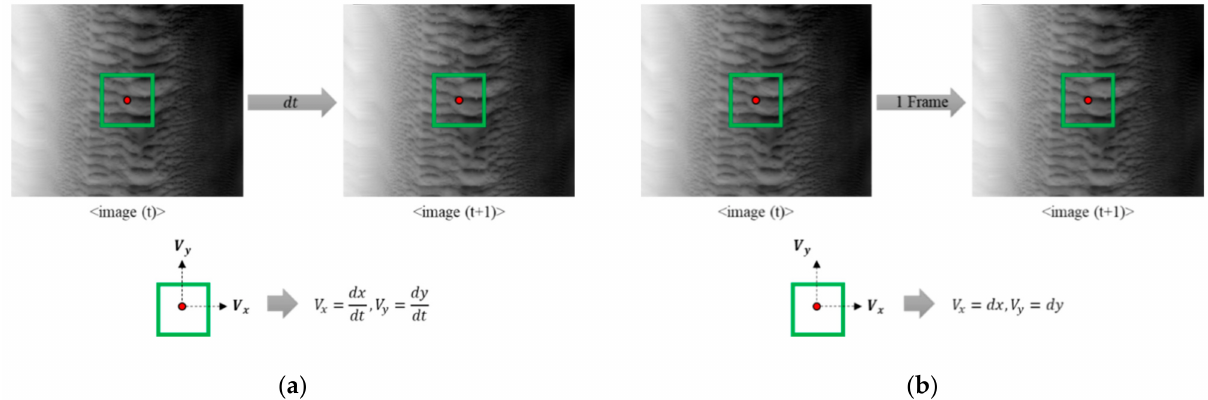
Figure 4. Comparison of the modified optical flow algorithm proposed in this study and the conventional optical flow algorithm: ( a ) modified and ( b ) conventional optical flow